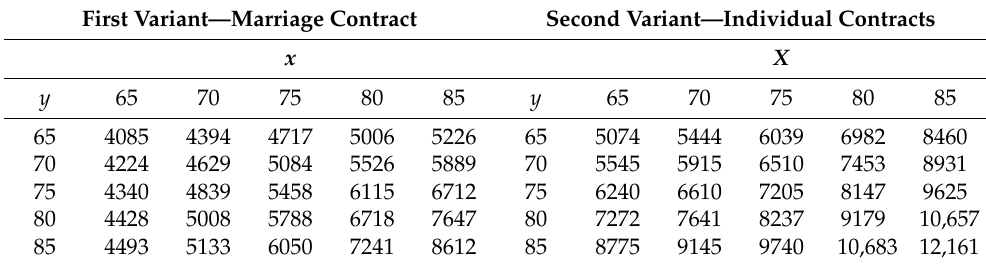
Table 4. Total benefits of equity release for various ages of spouses in two variants of